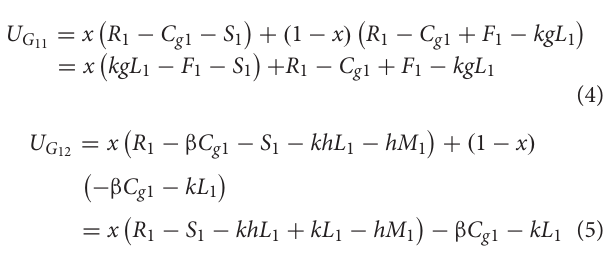
TABLE 1 | The benefit matrix between government and construction enterprises. Construction enterprises